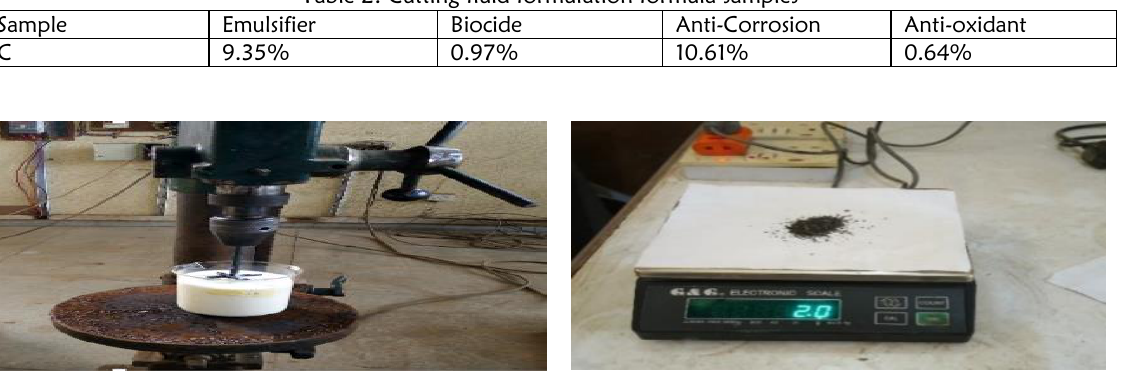
Table 2: Cutting fluid formulation formula samples